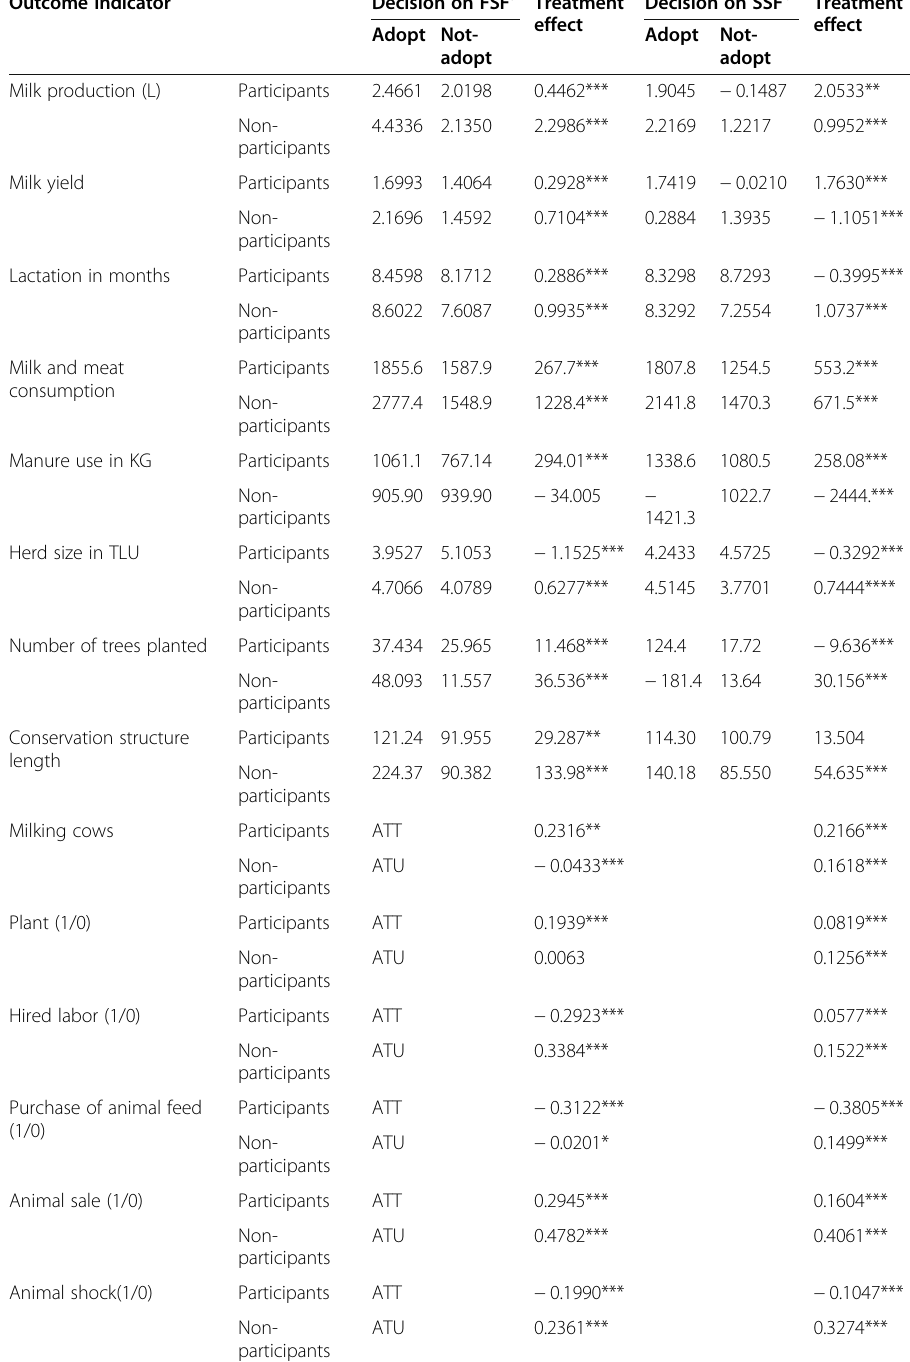
Table 8 Impact of SF on economic, ecological, and social welfare